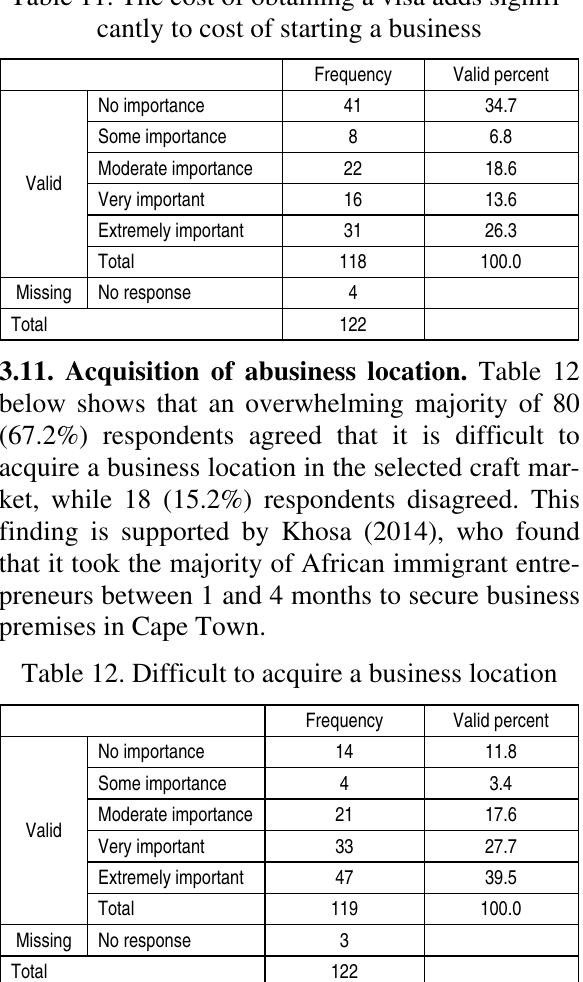
Table 11. The cost of obtaining a visa adds signifi-